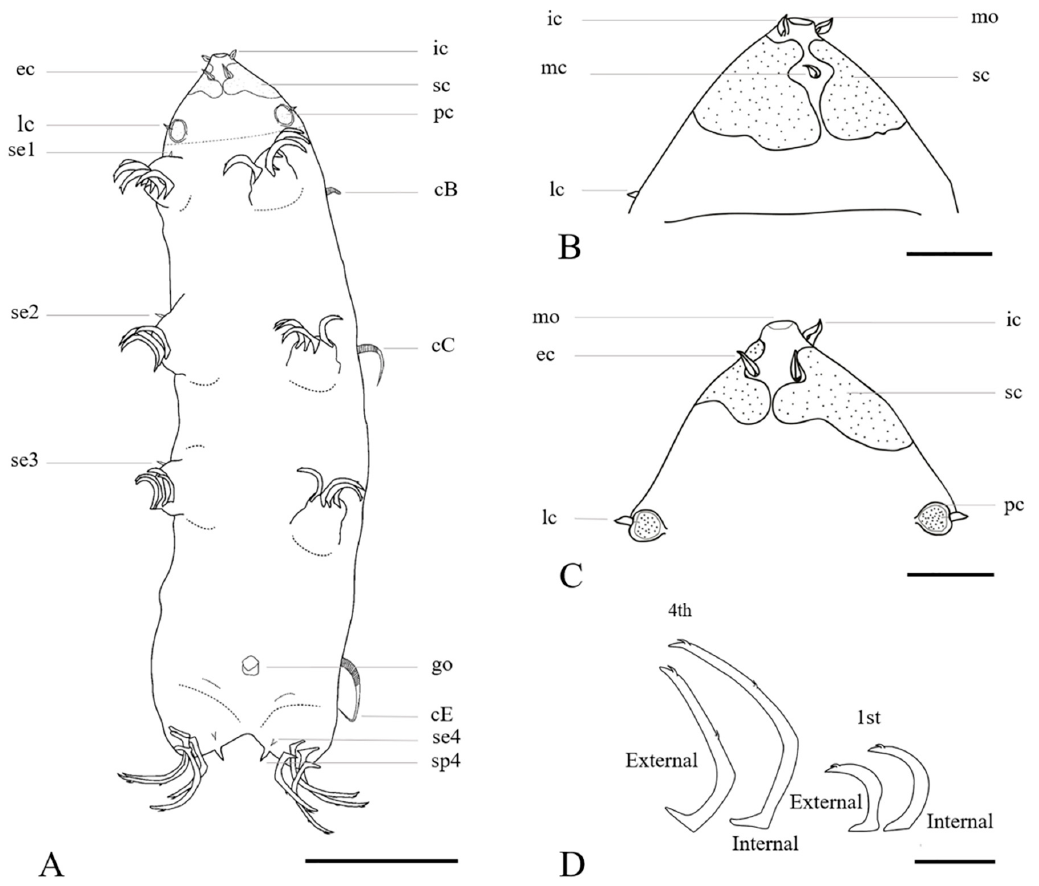
Figure 9. Coronarctus yurupari sp. nov. Drawings based on the holotype. ( A ) Ventral view of the body; ( B ) Dorsal view of the head; ( C ) Ventral view of the head; ( D ) Claws of the first and fourth pairs of